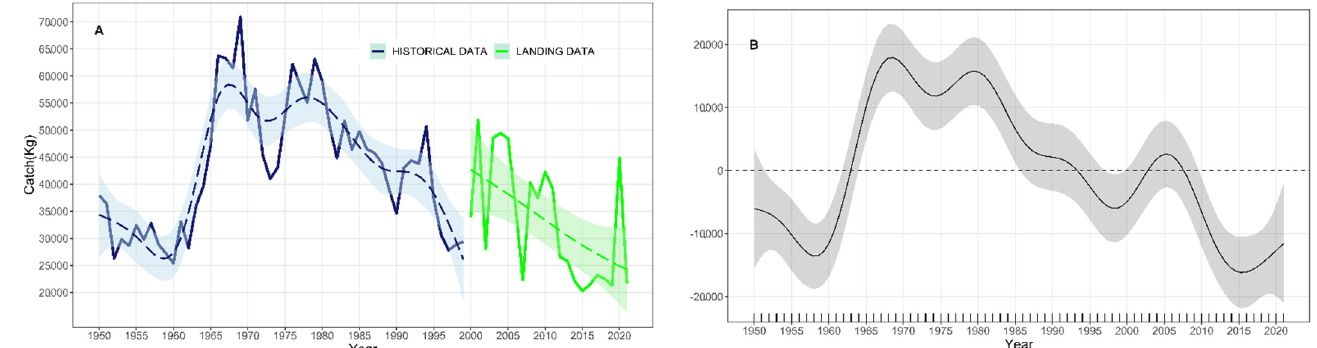
Figure 3. ( A ) Yearly distribution of Catch of S. dumerili for the period 1950–2021, obtained from both historical (blue) and landing (green) data. Dashed line is the smoothed trend estimated by the GAM method of the geom_smooth function. Blue and green shadows represent the confidence intervals. ( B ) GAM smooth splines of the response variable Catch as a function of the explanatory variable, Year and respective 95% confidence intervals.